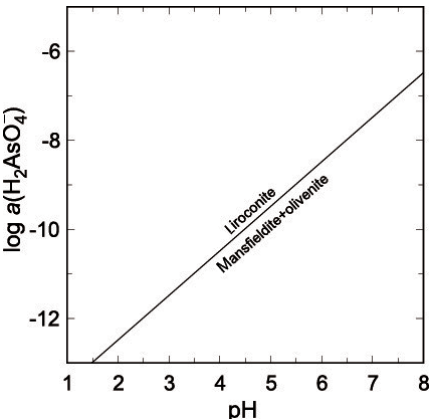
Figure 7. Stability fields of olivenite + mansfieldite vs. liroconite, according to Eq. (7) in